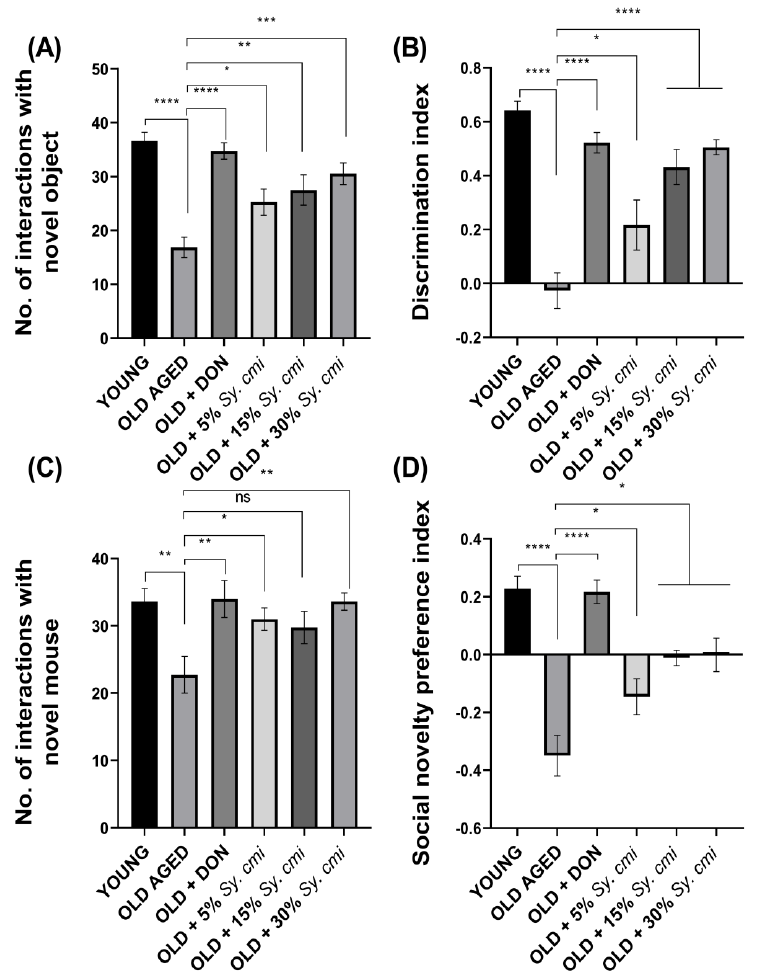
Figure 6. The mice ( n = 8) supplemented with 5, 15, and 30% dilutions of Sy. cmi for 16 months were tested for learning and memory in novel object and social recognition tests, and the animals’ cognition was tested by monitoring their remembrance of familiarity during a test phase of 5 min duration, and outcomes were expressed as ( A ) number of interactions with the novel object, ( B ) discrimination index, ( C ) number of interactions with the novel mouse, and ( D ) social novelty preference index. The outcomes of all groups were compared with the aged control group and * p < 0.05, ** p < 0.01, *** p < 0.001, **** p < 0.0001 were considered statistically significant while ns showed non-sgnificant outcomes for all data presented as mean ± SEM.